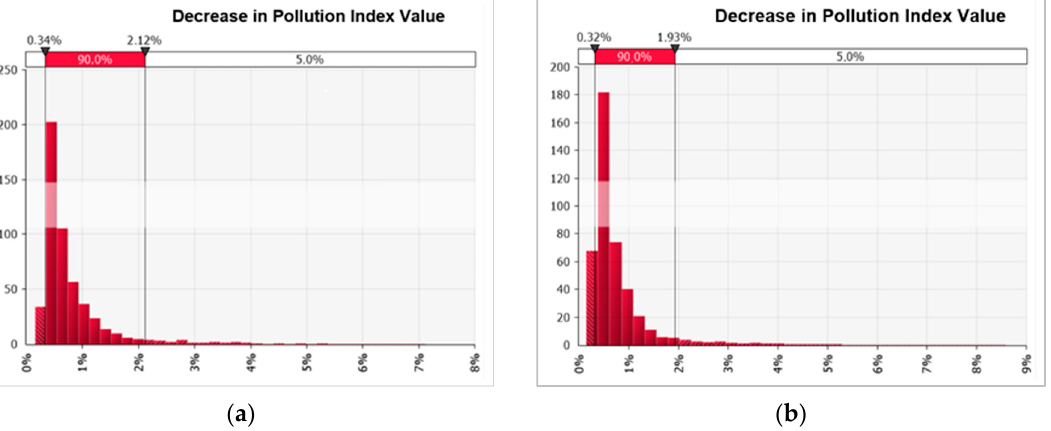
Figure 7. Percentage of reduction in pollution index in the program: ( a ) domestic waste handling; ( b ) livestock waste handling.